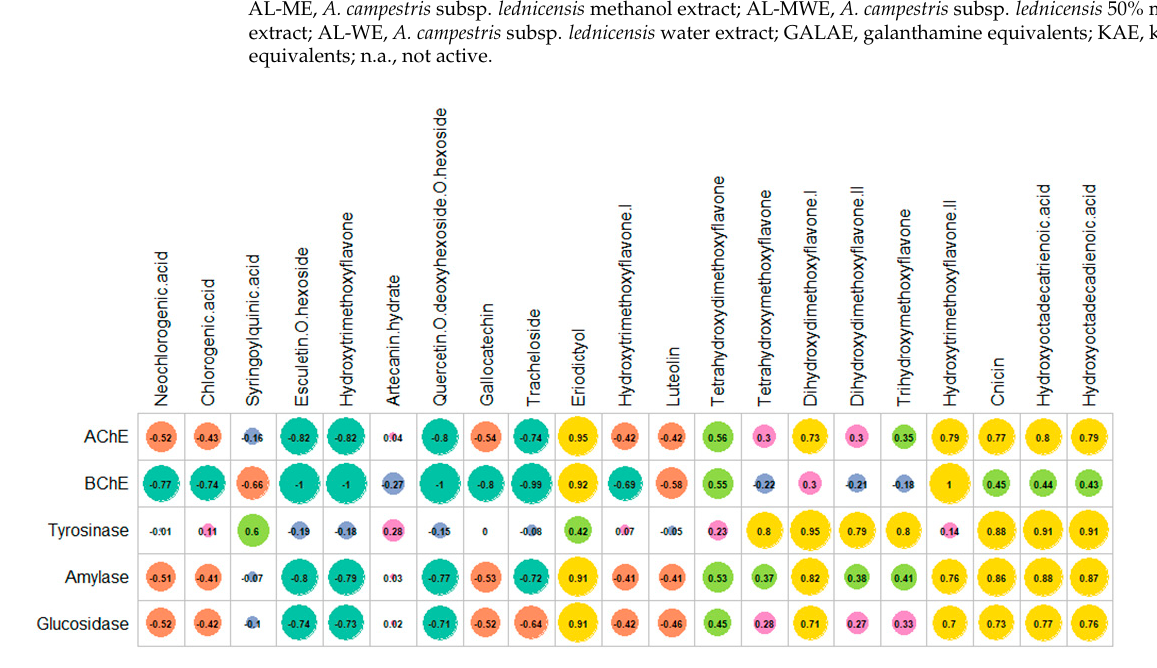
Figure 5. Pearson correlation between enzyme inhibitory activity and individual phytochemicals.